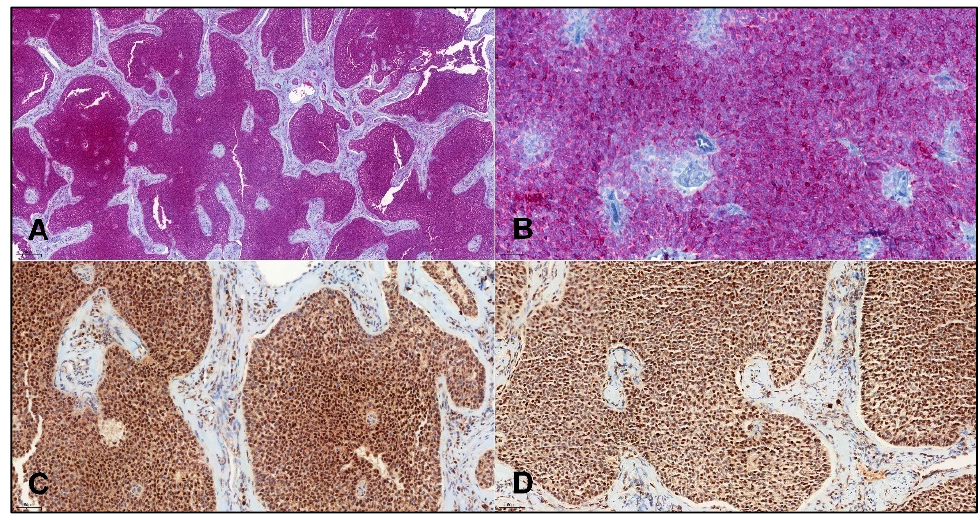
Figure 2. Representative images of IHC staining in adult granulosa cell tumors: Calretinin ( A ), original magnification ×50; inhibin alpha ( B ), original magnification ×200; SF1 ( C ), original magnification ×200; and FOXL-2 ( D ), original magnification ×200.